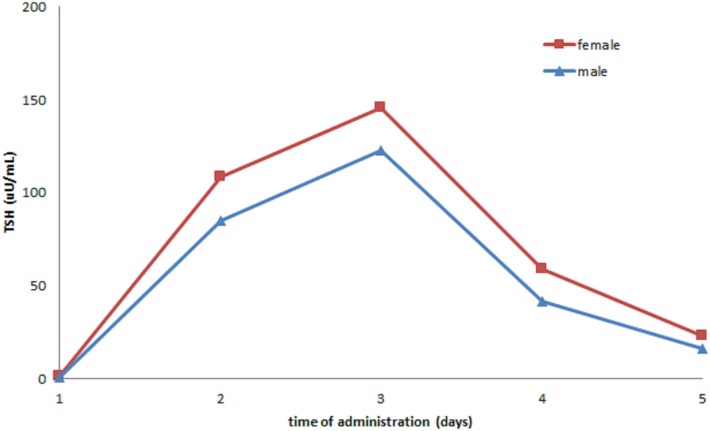
Distribution of TSH peaks by gender.